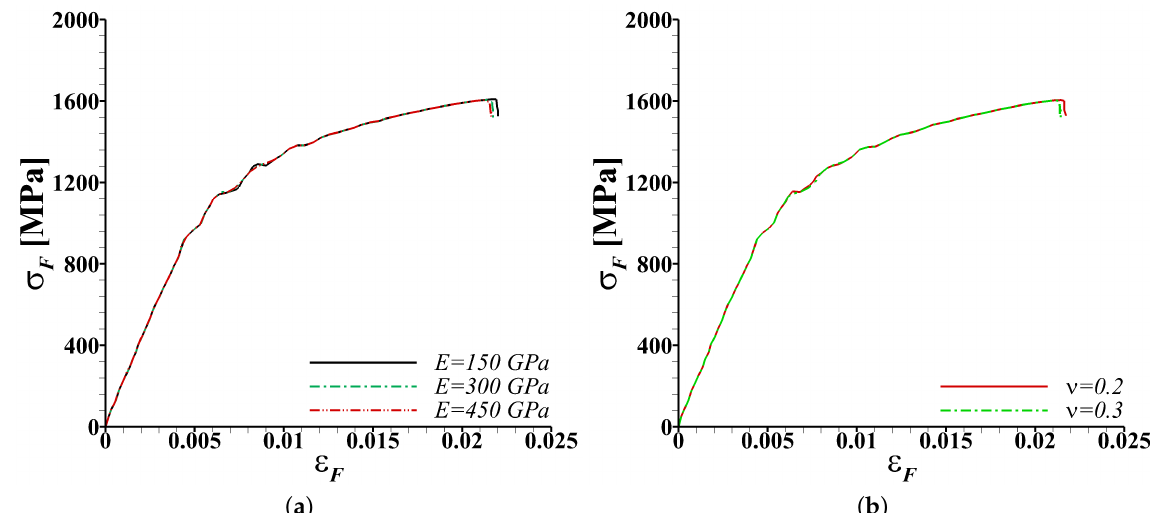
Figure 13. Effect of the elastic properties, ( a ) Young’s modulus and ( b ) Poisson’s ratio, of an inclusion of strength σ N = 800 MPa M ≈ 1.9 and σ ≈ 0.6) on the macroscopic flexural stress ( σ ( σ N / σ F N / σ 0 0